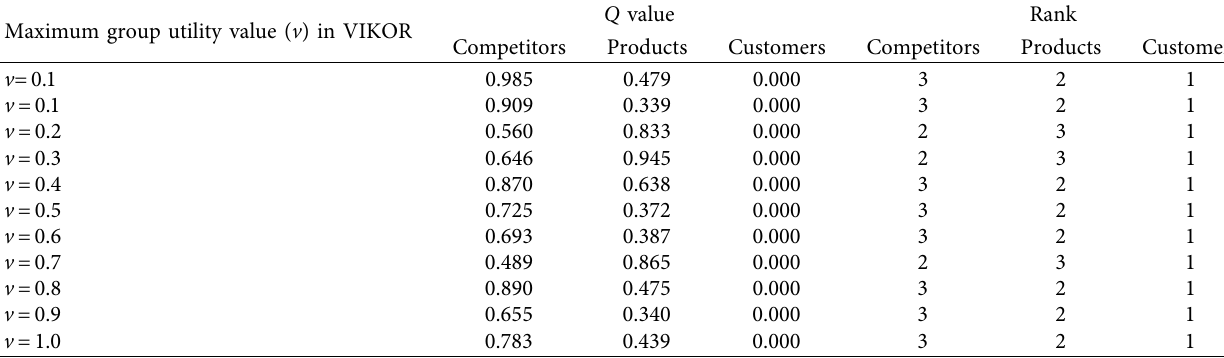
Table 14: Q values and rankings for each supplier in terms of v value change. Maximum group utility value ( v ) in